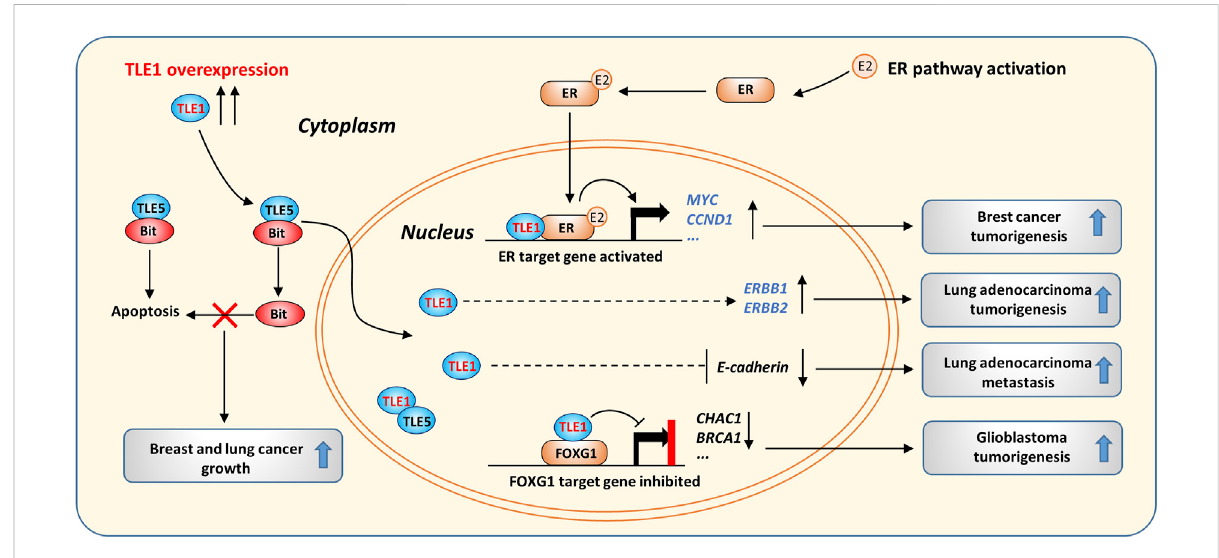
FIGURE 2 The oncogenic activity of TLE1 in cancer. TLE1 suppresses cytosolic Bit/TLE5-induced apoptosis by forming a TLE1/TLE5 complex, which is mainlylocalizedinthenucleus.TheERpathwayisactivatedinthepresenceofestrogen(E2),andpathwayactivationpromotesbreastcancergrowth. TLE1 forms a complex with activated ER and enhances ER target gene expression. TLE1 overexpression increases the expression of ERBB1/2 and induces EMT, which was found to contribute to lung adenocarcinoma tumorigenesis in transgenic mice. In GBM, the TLE1/FOXG1 complex suppresses a cluster of FOXG1 target genes, thereby promoting GMB tumorigenesis by activating the Notch signaling